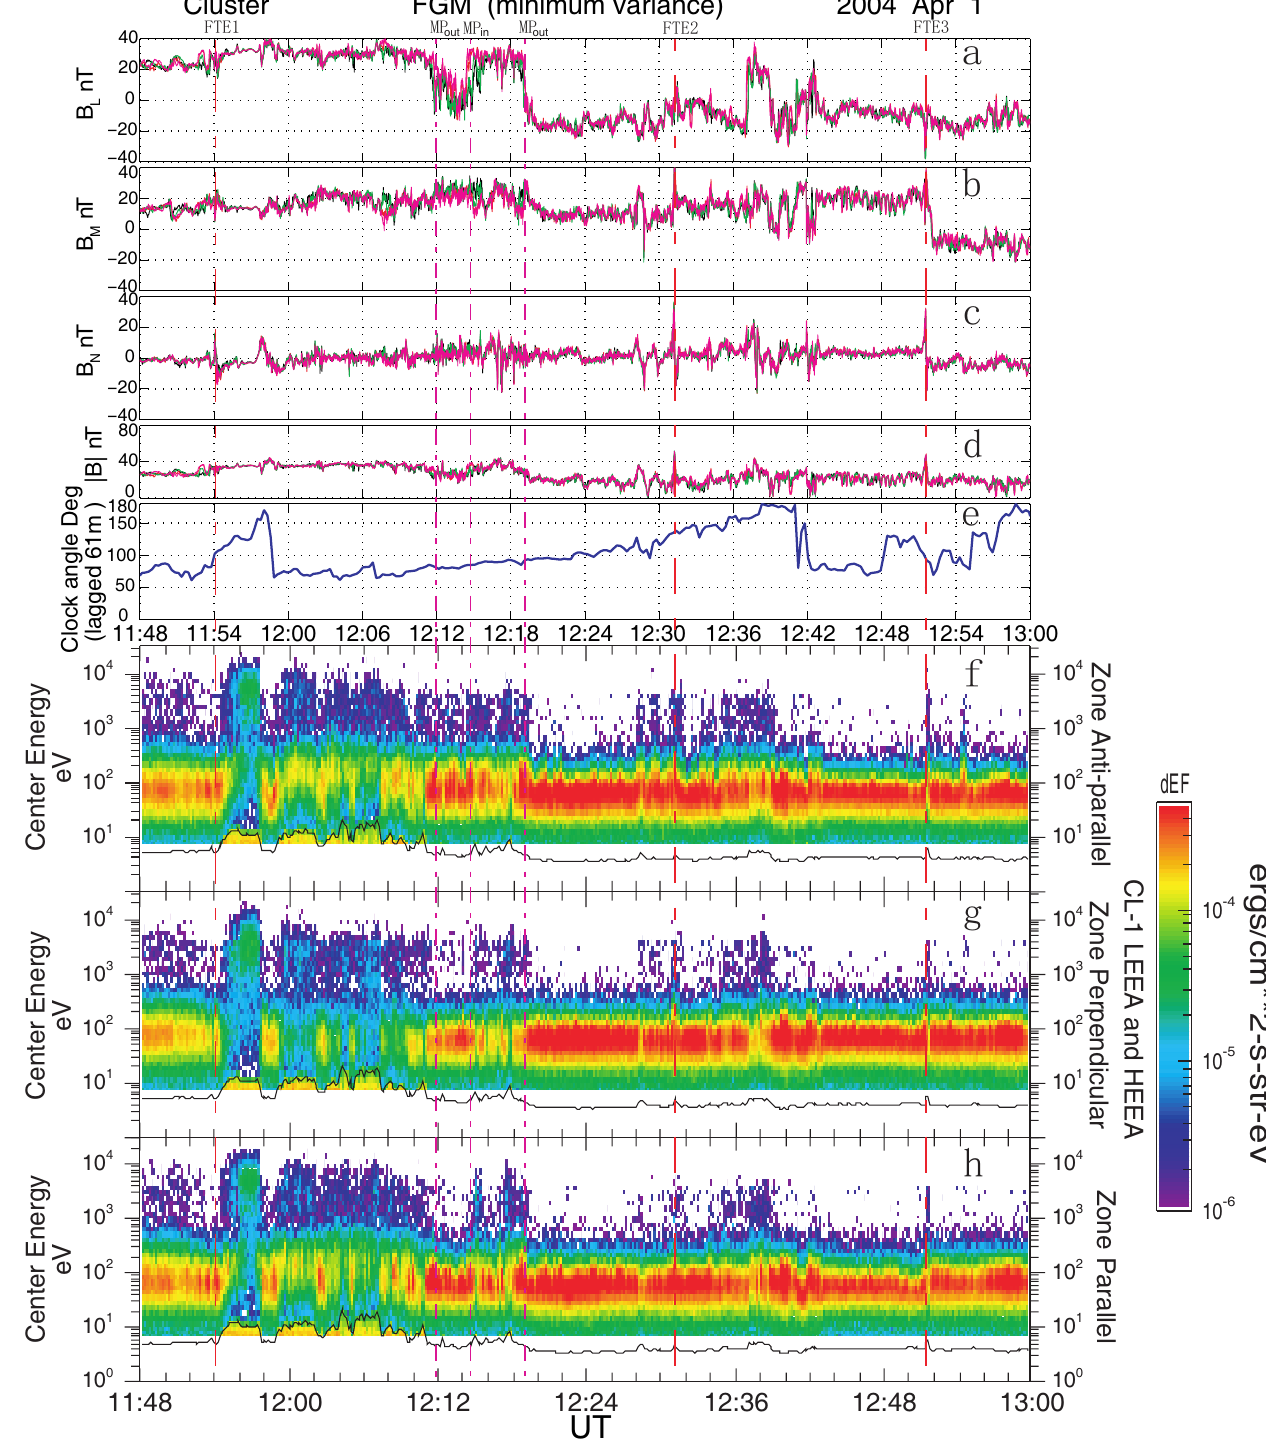
Fig. 2. An overview of the FGM measurements which are projected onto LMN coordinates, and IMF clock angle which are lagged by 61min, together with the spectrograms of spin-averaged, differential electron energy flux in anti-parallel, perpendicular, and parallel directions from the HEEA and LEEA sensor of PEACE on the Cluster S/C 1, between 11:48 and 13:00UT on 1 April 2004. The three large, typical FTEs at 11:54:10, 12:31:16 and 12:51:41UT are highlighted by red dashed vertical lines, and the magnetopause crossings by purple dashed vertical